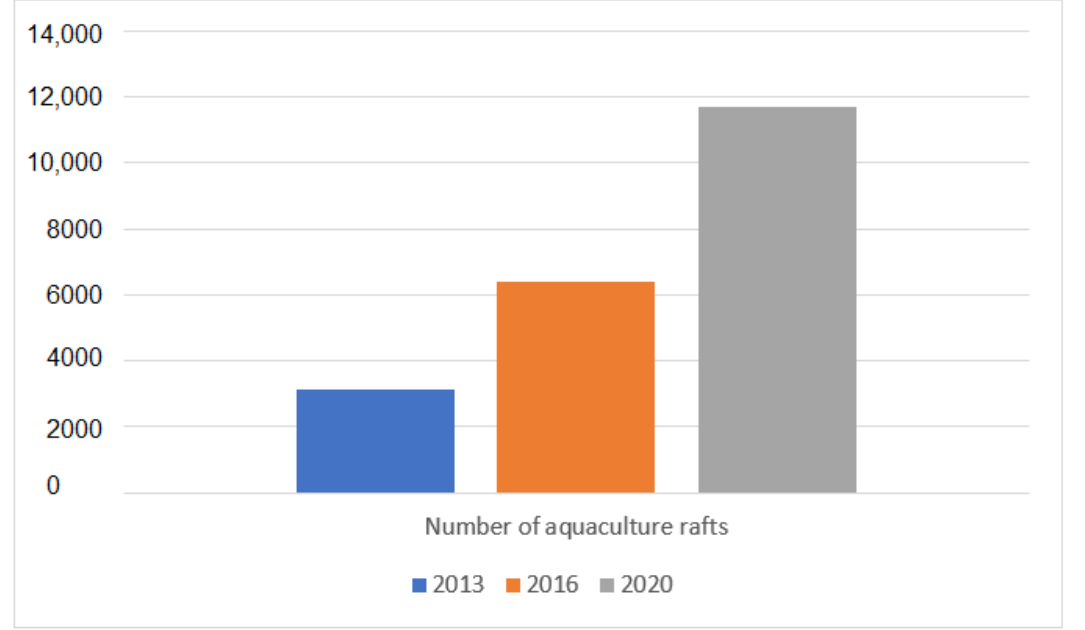
Figure 8. Haizhou Bay aquaculture zones: ( a ) 2013; ( b ) 2016; ( c ) 2020.